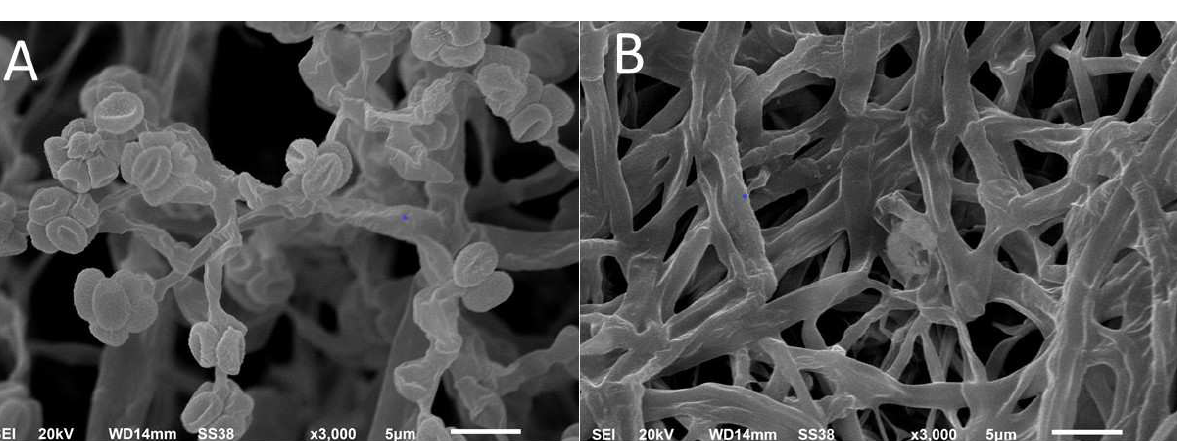
Figure 3. Mycoparasitism of Trichoderma asperellum ZNW on Globisporangium ultimum NZW (after their first contact in a dual culture) under the scanning electron microscope. ( A ): overgrowth of T. asperellum ZNW hyphae (T-arrow) on G. ultimum NZW hyphae (G-arrow), ( B ): coiling of T. asperel- lum ZNW hyphae around G. ultimum NZW hyphae, ( C ): continuous coiling, ( D ): the breakdown (br